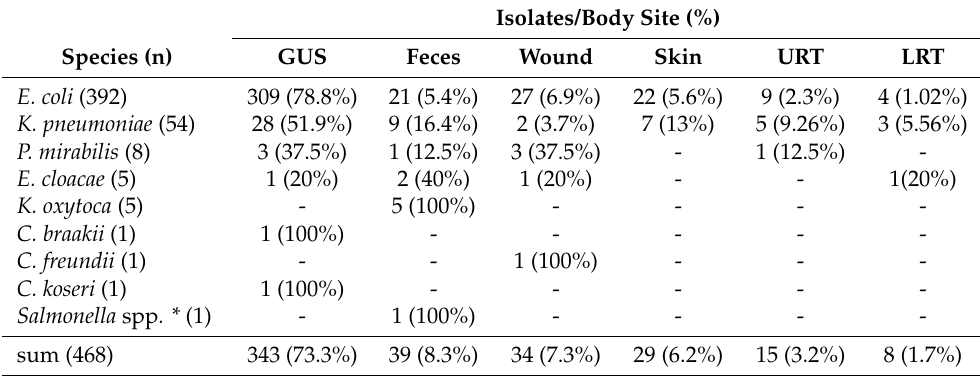
Table 1. Overview of the body site origins of the